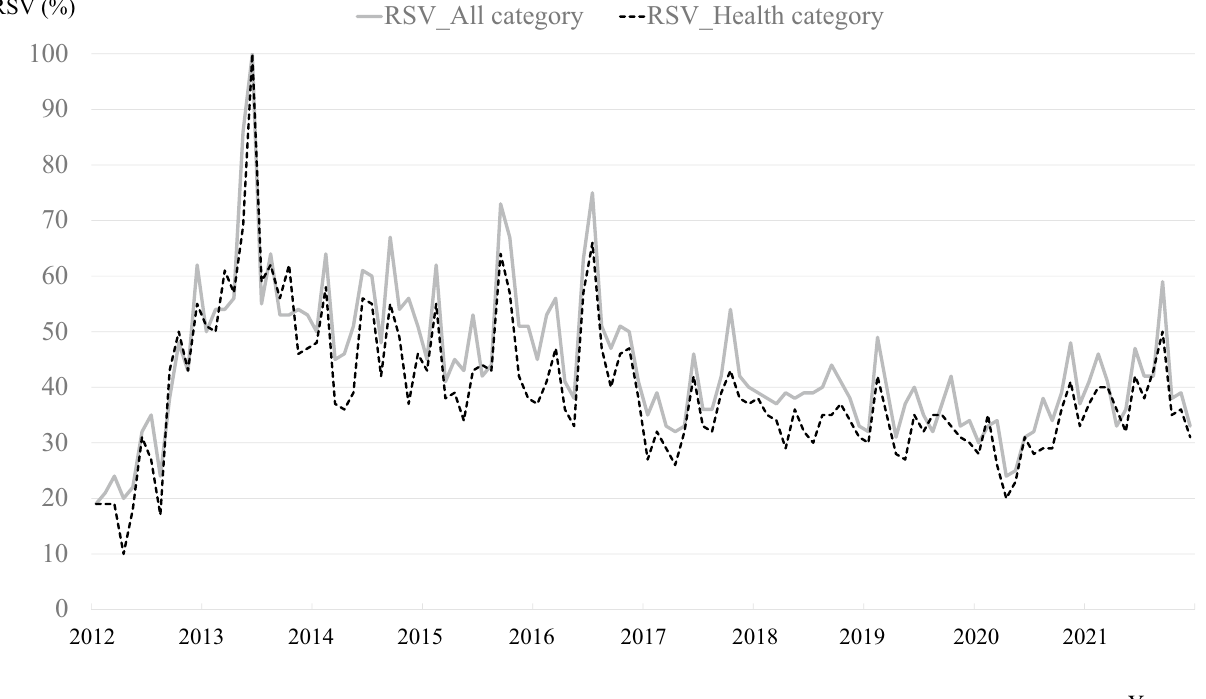
Figure 1. Monthly trends of relative search volume (RSV) for “Shikyuu-keigan” in Google Trends from 2012 to 2021. Data from the “All” and “Health” categories are depicted with solid and dotted lines,